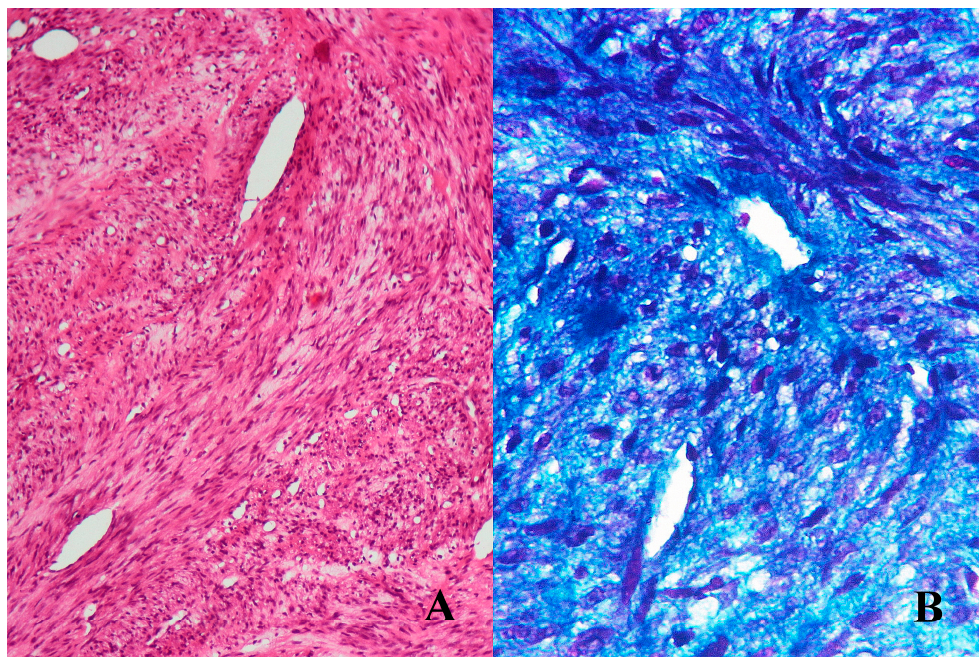
Figure 2. ( A ) (100×) Hematoxylin and eosin stained section shows fascicular and cellular areas characterized by polygonal cells at the center and elongated cells at the periphery. ( B ) (400×) Masson’s trichrome stain highlights the highly fibrous stroma.